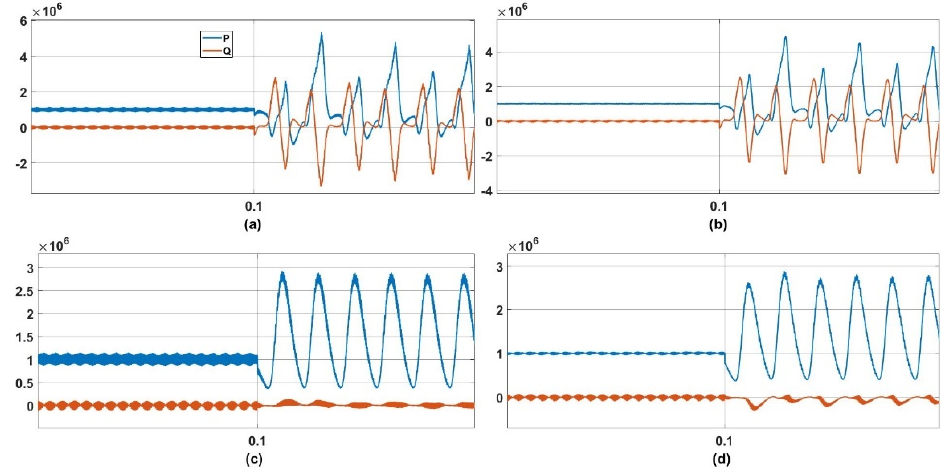
Figure 28. Power flow in symmetrical fault in the case of ( a ) 2L- αβ , ( b )3L- αβ , ( c ) 2L-dq and ( d ) 3L- dq.